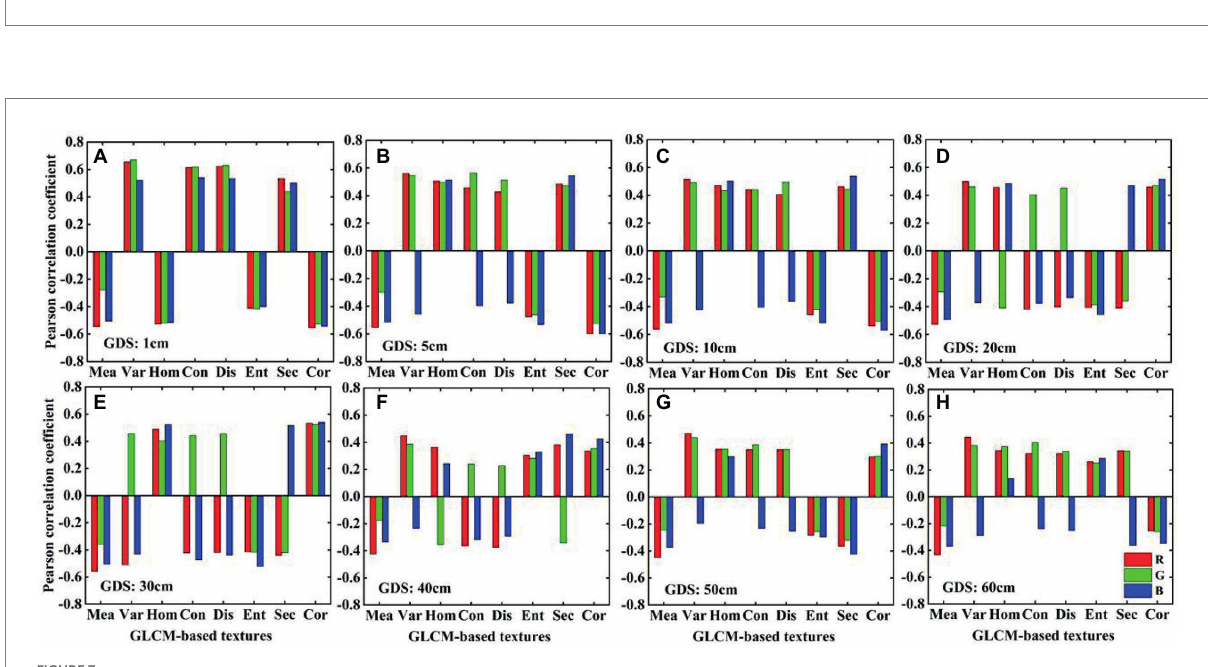
FIGURE 7 The relationship between different ground resolution (GDS) GLCM-based textures and AGB. (A) 1, (B) 5, (C) 10, (D) 20, (E) 30, (F) 40, (G) 50, (H) 60 cm image